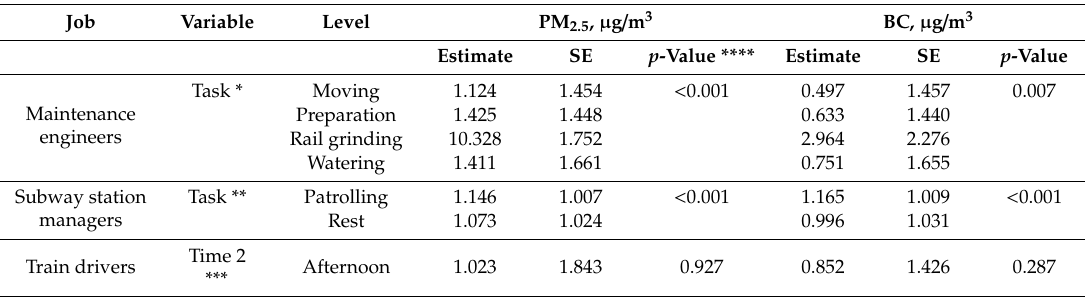
Table 3. Multiplicative e ff ects of factors on the GM of PM 2.5 and BC exposure levels using linear mixed model analysis † .